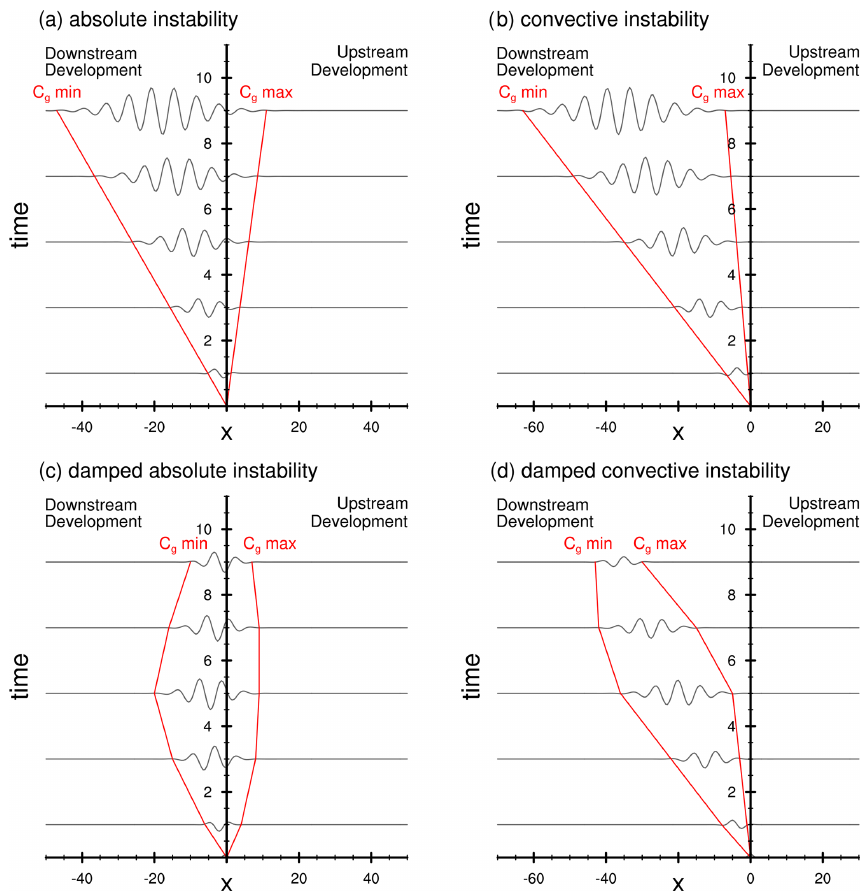
Figure 2. Absolute (a, c) and convective (b, d) instability conceptually represented in the x – t plane for an unstable easterly flow. If C g = 0 within the cone, then there is both upstream and downstream development, and the flow is absolutely unstable (a) . Otherwise, the flow is convectively unstable (b) . If the growth of the wave packet is sufficiently damped as in panels (c) and (d) , the amplitude of the wave packet will eventually decay to zero, resulting in weaker waves and a shorter-lived wave packet. Adapted from Diaz and Aiyyer